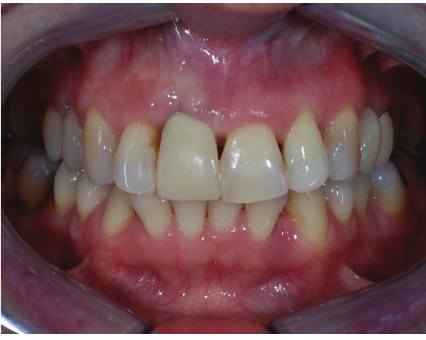
Figure 21: Frontal view after application of the provisional inte- grated abutment